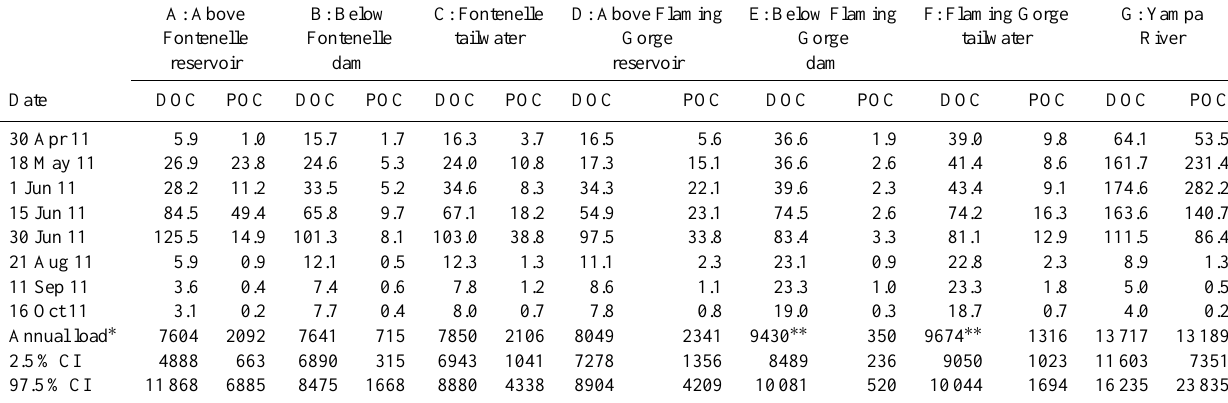
Table 3. Daily measured fluxes (Flux d , td − 1 ) and annual load (tyr − 1 for 2011) of dissolved organic carbon (DOC) and particulate organic carbon (POC) across sampling sites on the Green and Yampa rivers. Letters A–G preceding the site names correspond to sites A–G in Fig.